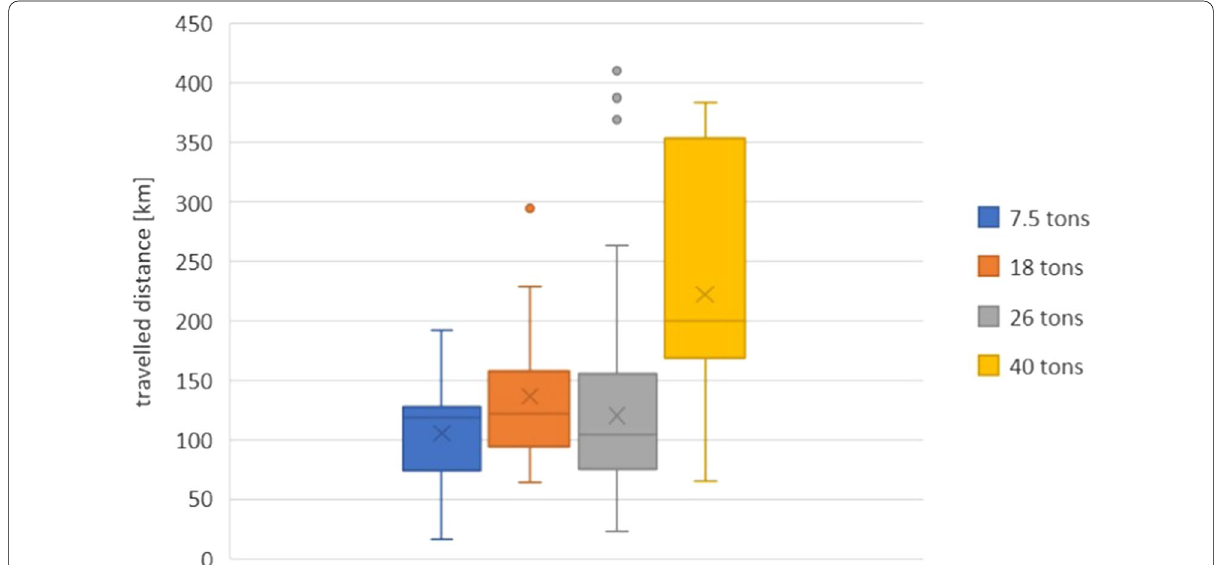
Fig. 2 Calculated driving distances of FCEVs